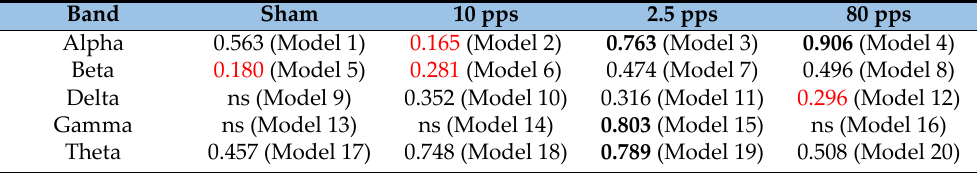
Table 7. Confusion matrix results ( kappa ) for the 20 models in Phase 2. Values in bold are in the upper quartile of all 16 values, and those in red in the lower quartile (‘ns’ indicates mean overall accuracy < 0.33).